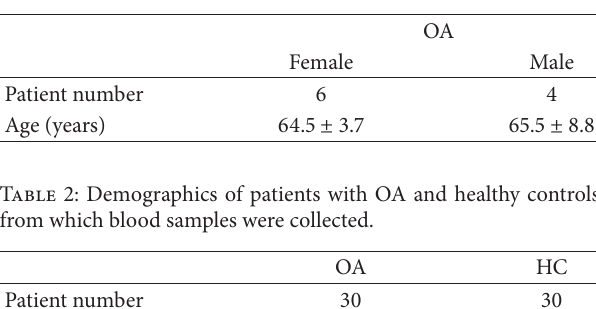
Table 1: Demographics of patients with OA from which synovial tissues were obtained from knee replacement surgeries.